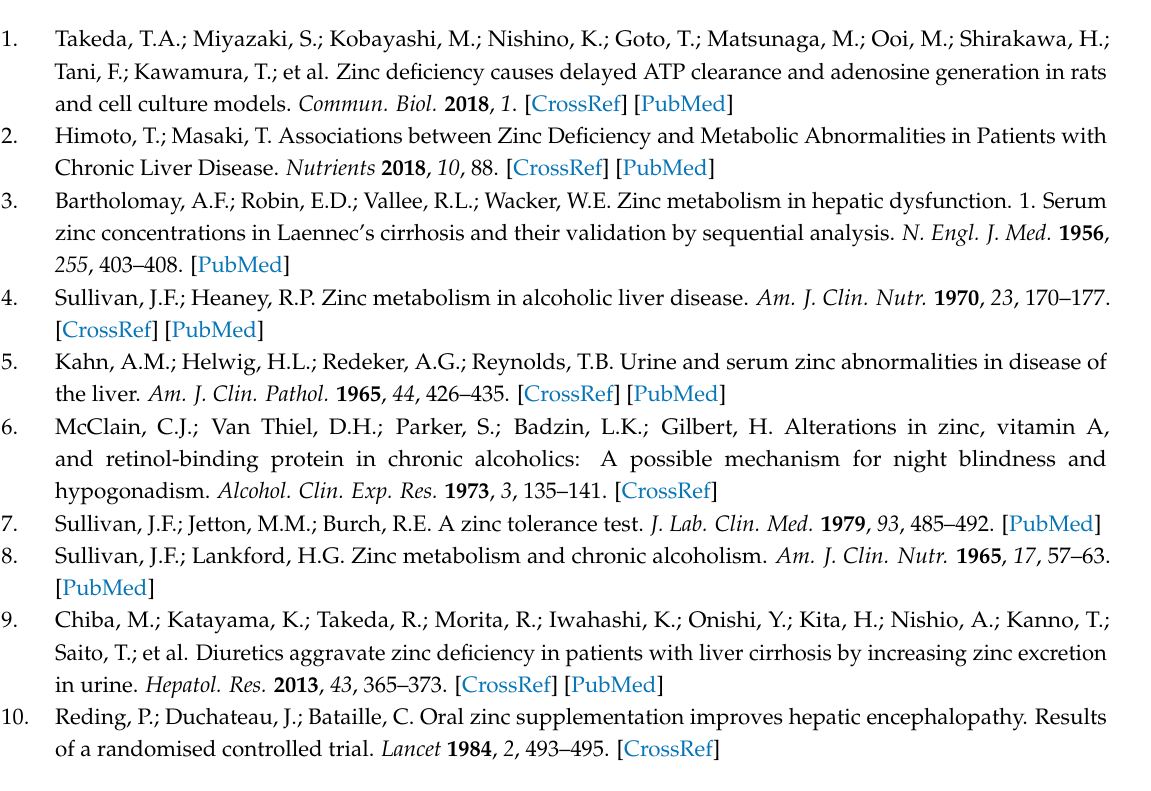
backgrounds in the Zn- and no Zn-treatment